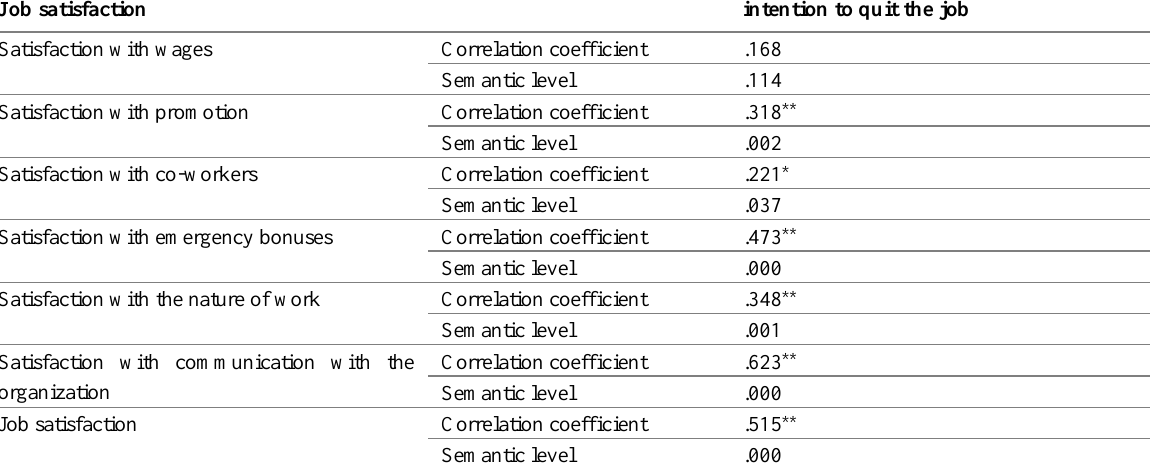
Table 1: Pearson correlation coefficient between job satisfaction and its sub-dimensions and intention to leave the job Job satisfaction intention to quit the job Satisfaction with wages Satisfaction with promotion Satisfaction with